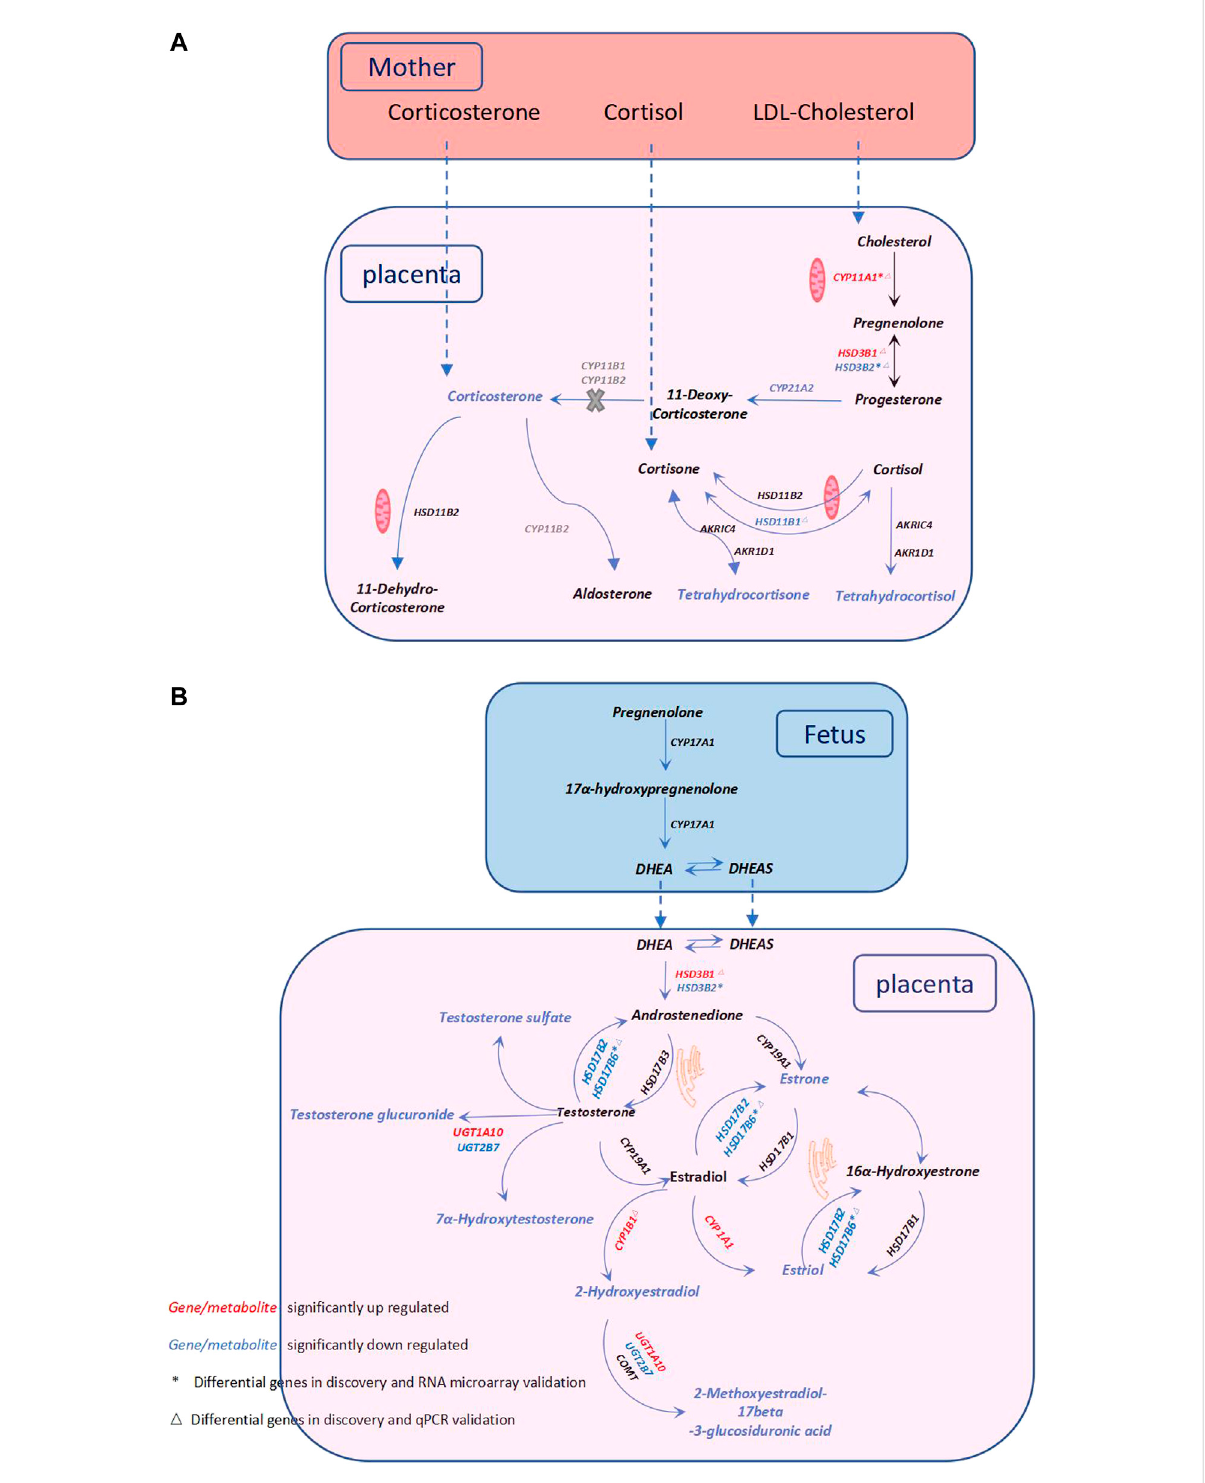
FIGURE 3 Metabolic pathway alterations in PE — Steroid hormone biosynthesis. (A) Description of glucocorticoid metabolism. (B) Description of sex hormonemetabolism.SteroidhormonesaresynthesizedfromcholesterolmainlythroughthecatalysisofthecytochromeP450( CYP )familyandthe hydroxysteroid dehydrogenase ( HSD ) family. The catalysis of cholesterol is initiated by CYP11A1 , and cholesterol is subsequently metabolized into glucocorticoids, mineralocorticoids, and sex hormones. The dysregulation of glucocorticoid metabolism and sex hormones in the PE placenta is illustrated in (A) and (B) , respectively. Red and blue fonts indicate signi fi cant increases and decreases, respectively. * Differential genes in the discovery and RNA microarray validation. △ Differential genes in the discovery and qPCR validation. The genes in grey represent they are lack in the placenta, and the X in grey indicates that this reaction is blocked in the